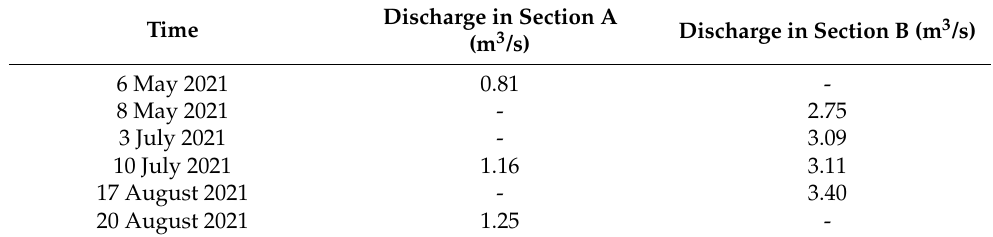
Table 3. Discharges of two sections in different